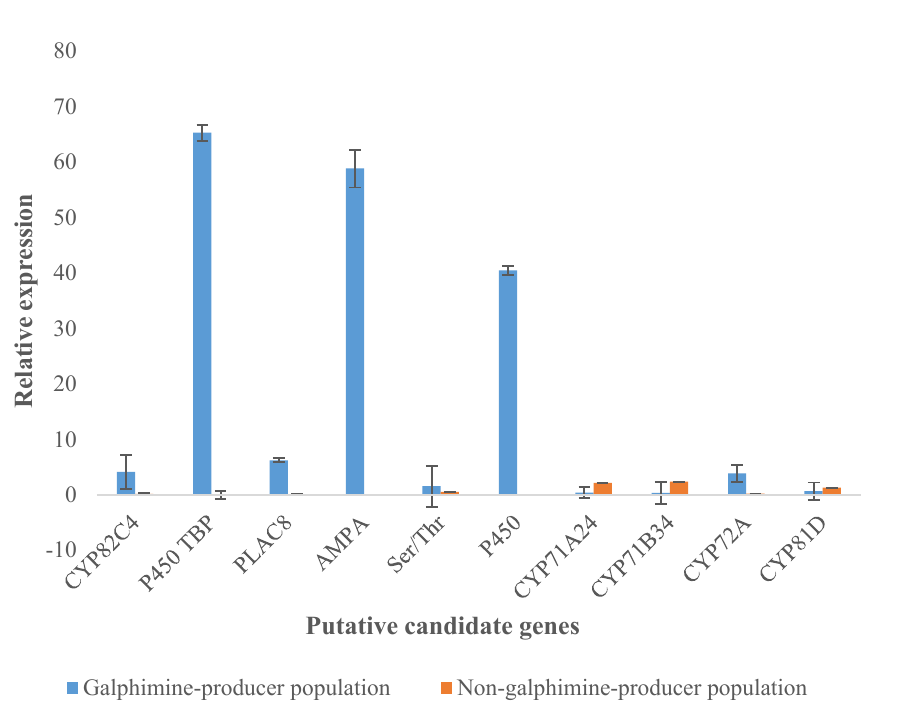
Figure 7. Relative expression of putative candidate genes in leaves of galphimine producer plants (GP) and non-galphimine producer plants (NGP) was calculated by the 2 − ∆∆ Ct method in quantitative PCR analysis. Y-axis represents the fold change value between GP and NGP. AMPA (5’-AMP-activated protein kinase), Ser/Thr (serine/threonine-protein kinase AtPK2/AtPK19).